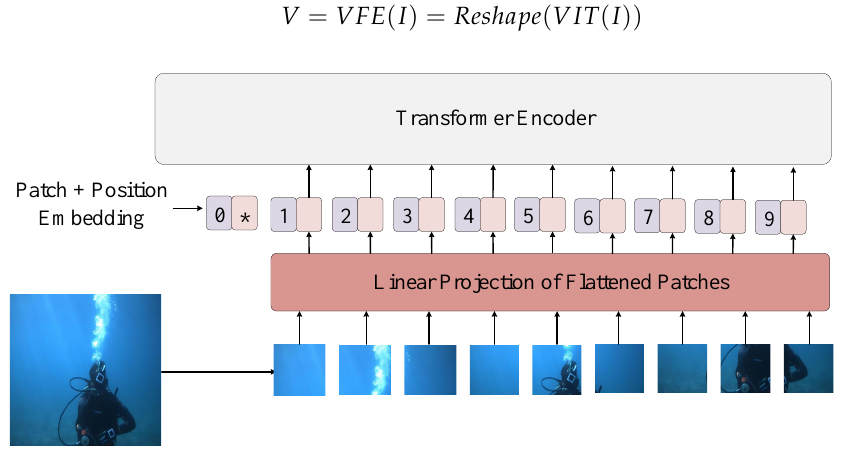
Figure 5. The overall structure of the VIT